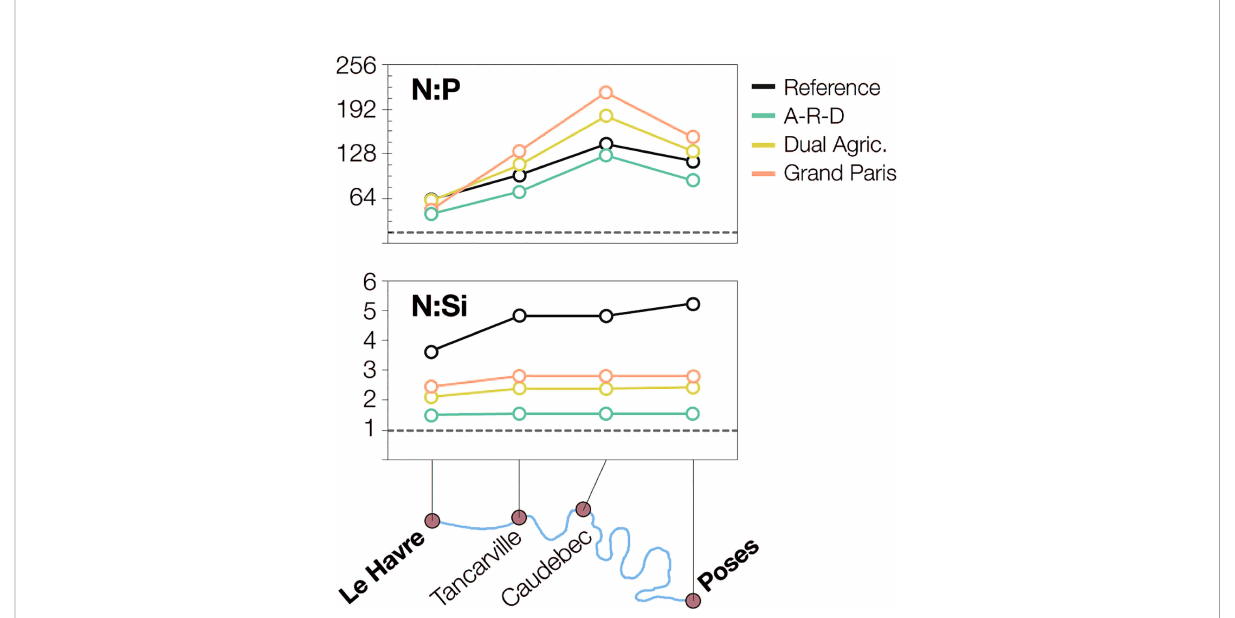
FIGURE 7 Stoichiometry (molar ratios) of nutrients in four stations along the estuary. The grey dotted lines mark the Red fi eld ratio (N:P = 16, N:Si =